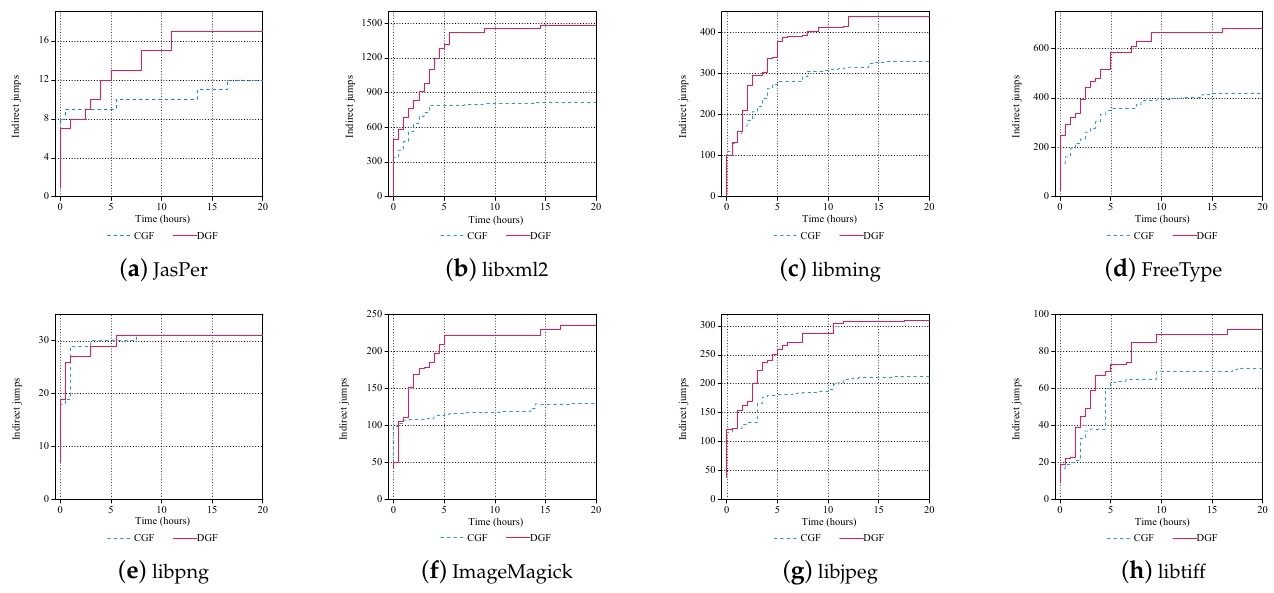
Figure 7. The number of indirect jumps resolved by two approaches on 8 benchmarks. The red line represents our DGF-based approach (DGF-CFGConstructor), and the blue line represents the CGF-based approach